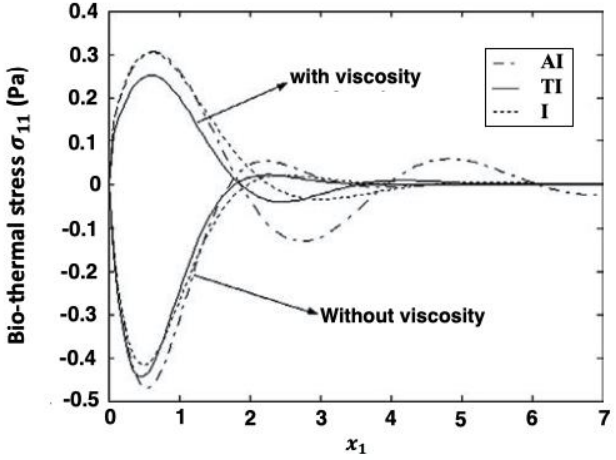
Figure 3. Biothermal stress 𝝈 𝟏𝟏 wave fluctuations along 𝒙 𝟏 – axis for different soft tissues.